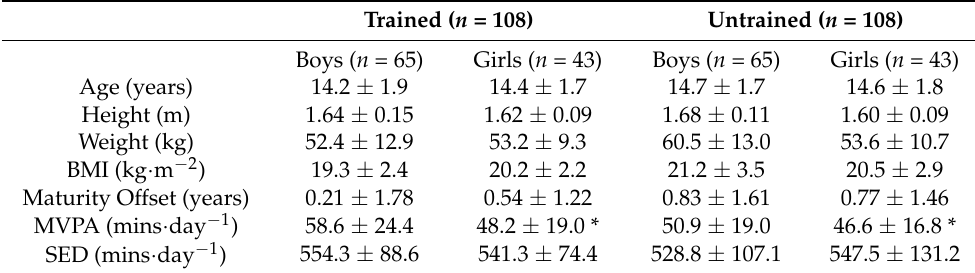
Table 1. Descriptive characteristics.